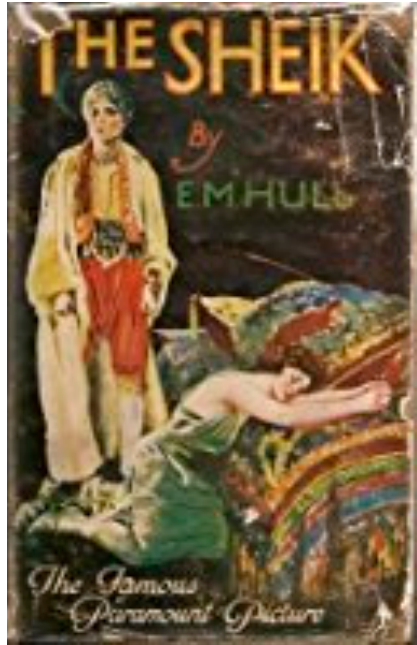
Figure 4. The Sheik by Edith Maud Hull 1919.